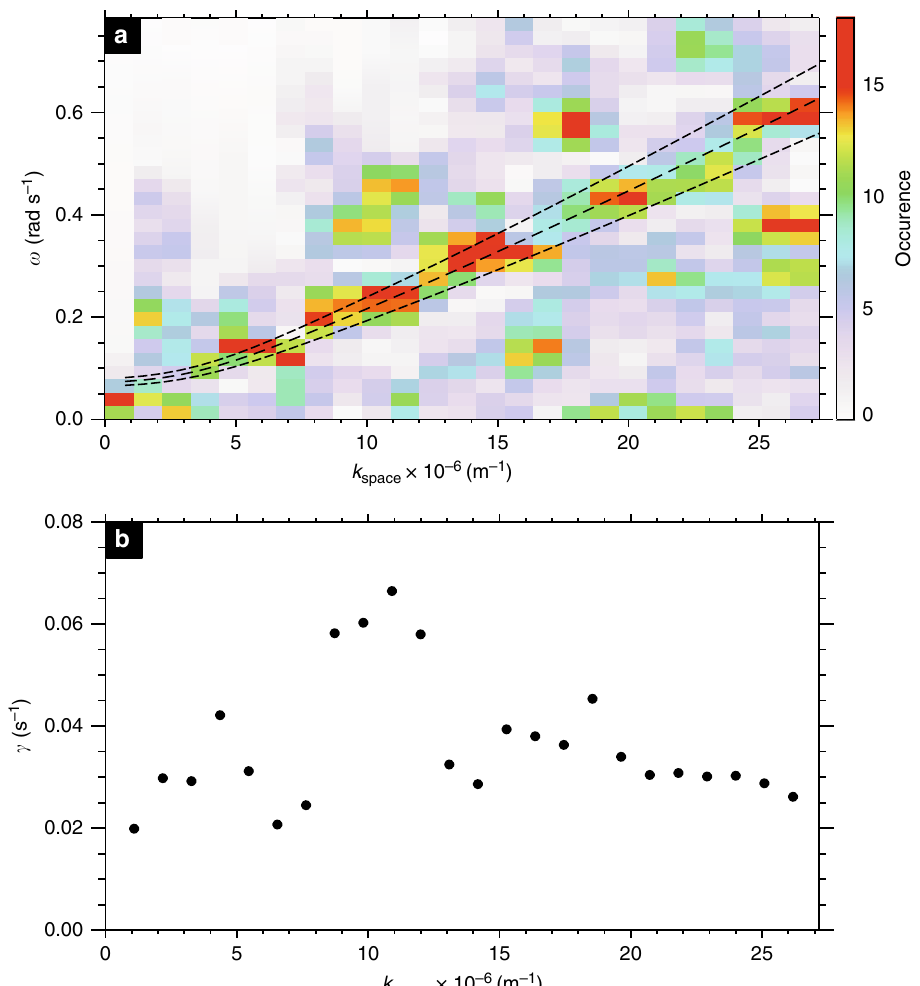
Fig. 2 A comparison of the observational dispersion relation with solutions to the warm plasma dispersion relation in the near-Earth magnetotail using realistic plasma parameters. a Observational dispersion relation shown in colour, along with analytical solutions to the full warm plasma dispersion relation for an in fi nite uniform plasma (dashed lines — central dashed line shows solutions for a parallel wavelength of approximately 1.8R E , and the dashed-dot lines indicate parallel wavelengths of 1.8R E ± 10%). A sensitivity analysis of the solutions to the warm plasma dispersion relation with respect to varying the magnetic fi eld, number density and temperature can be found in Method. b Observational growth rates (imaginary part of the frequency) as a function of wavenumber that demonstrate that these wavenumbers are growing exponentially, as would be expected in the linear stage of an